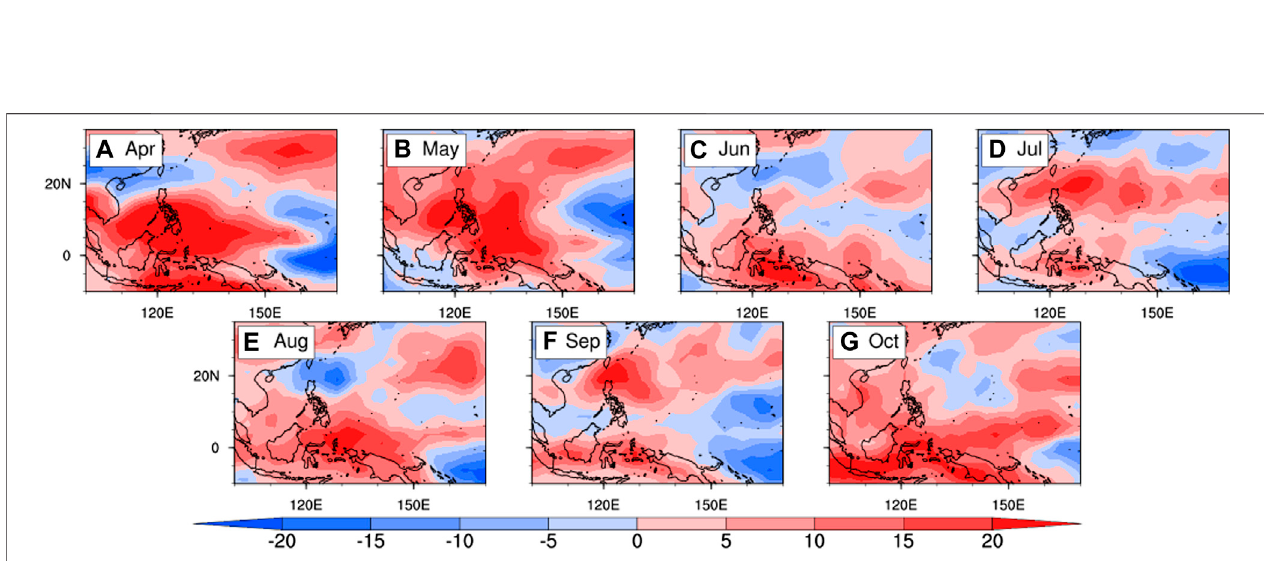
FIGURE 13 | Composite differences of (A) April, (B) May, (C) June, (D) July, (E) August, (F) September, and (G) October mean OLR anomalies (shading; unit: W m − 2 ) between the extreme high and low years of U500 BOB,4 .